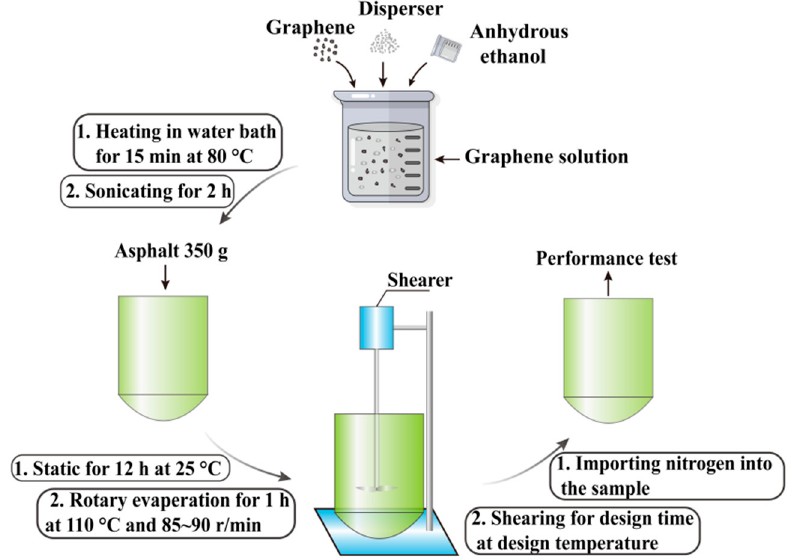
Figure 1. Graphene-modified asphalt preparation process.